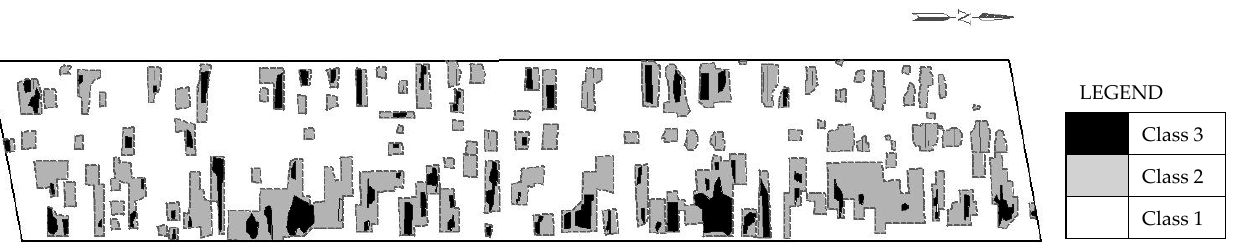
Table 7. Comparison of parameters for NDE data collected in this study with past studies.